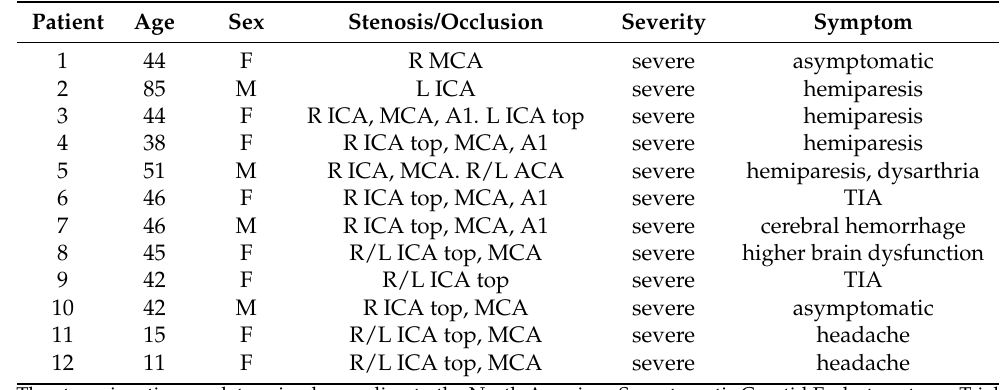
Table 1. Patient characteristics and clinical